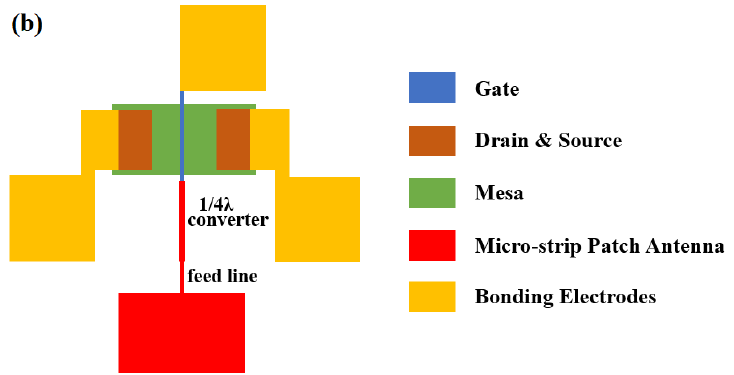
Figure 3. ( a ) The diagram of the micro-strip patch antenna, ( b ) the overall top view diagram of the GaN HEMT THz detector.